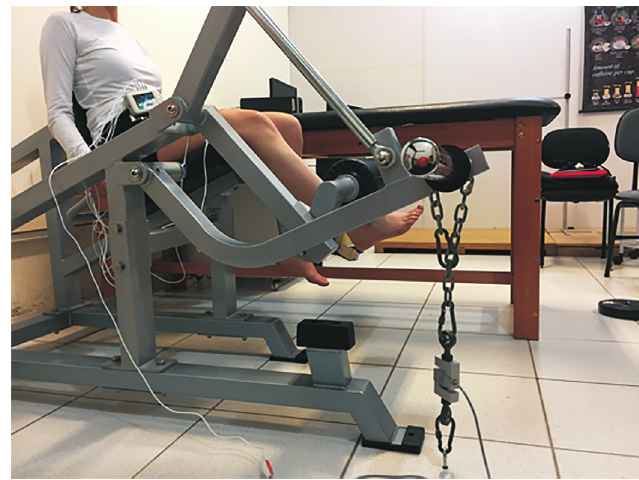
Figure 1 - Data collection of MVIC.